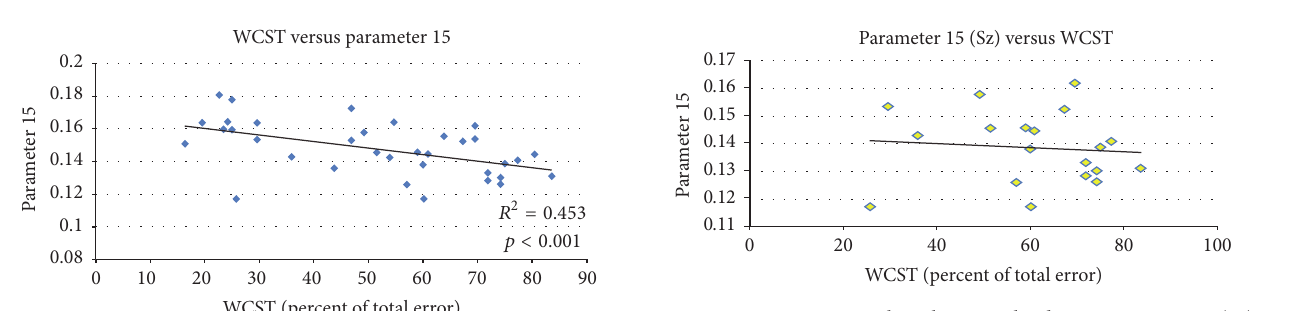
Figure 5: Regression analysis between loading parameters 15 (Sz) and the percentages of total error on the WCST. There is no significant difference in patients only between loading parameter and percentage of total error in the